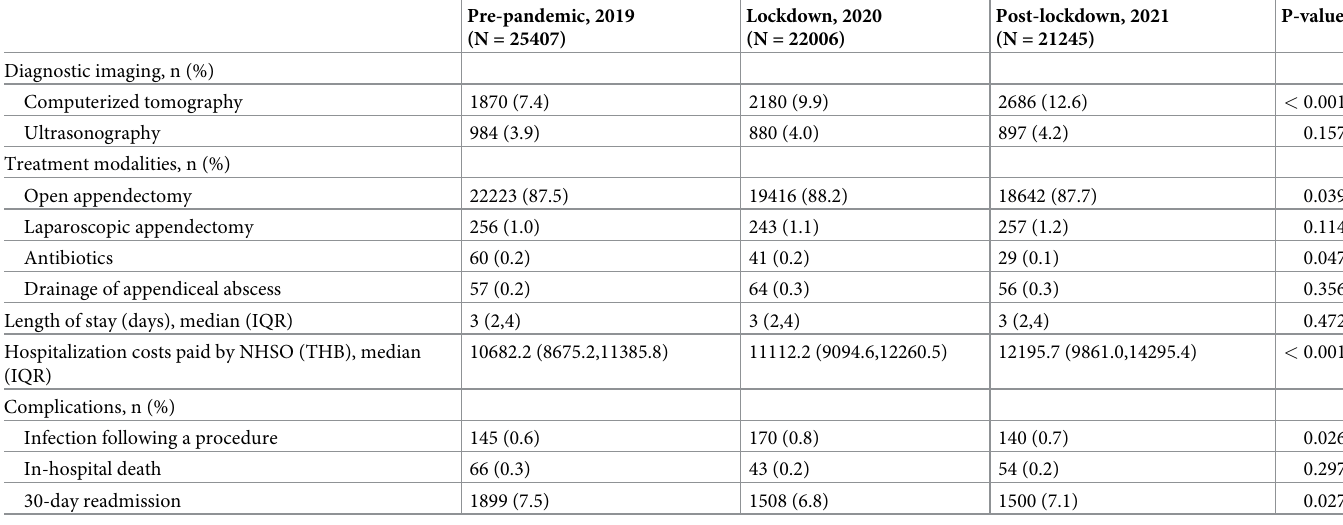
Table 2. Clinical management and patient outcomes for acute appendicitis during the three study